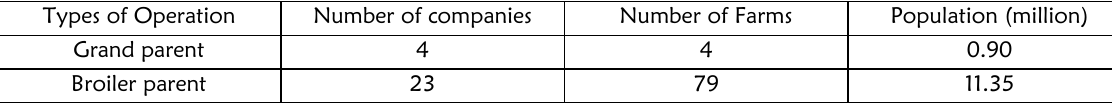
Table 1: Statistics of chicken production in Peninsular Malaysia (2010-2013). (Syauqi et.al 2015) Types of